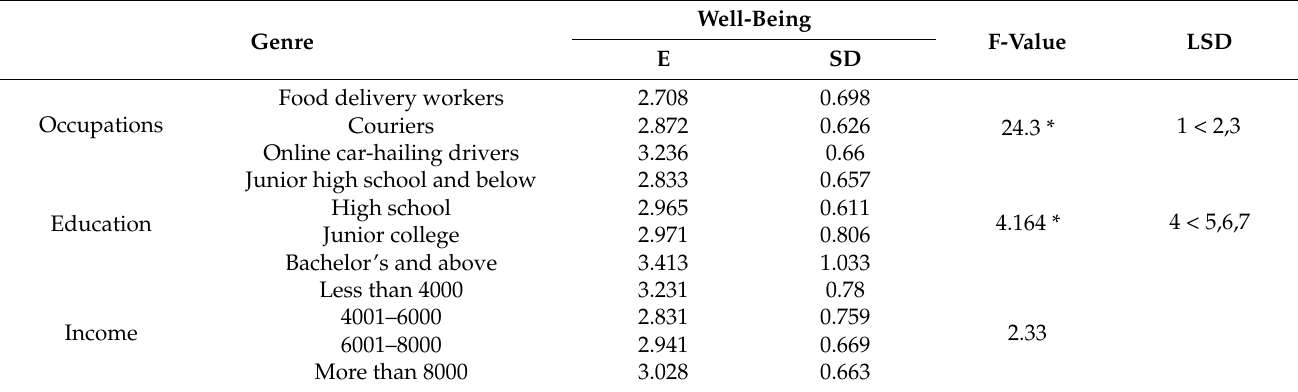
Table 6. Differences in Well-being on Various Factors.